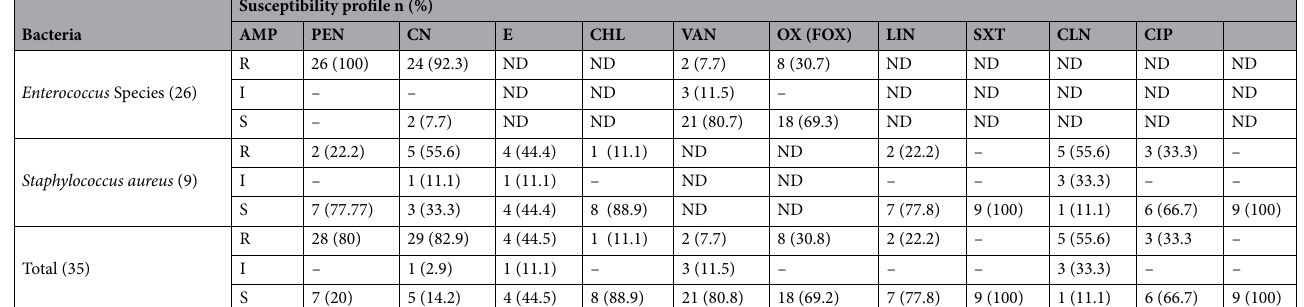
Table 6. Antibiotic susceptibility profile of Gram-positive bacteria isolated from newborn suspected of sepsis at Hawassa University Comprehensive specialized Hospital February 2021 to November 2021 (n = 35). AMP Ampicillin, P Penicillin, CN Gentamicin, E Erythromycin, CLN Clindamycin, SXT sulfamethoxazole- trimethoprim, CIP Ciprofloxacin, OX Oxacillin, VAN Vancomycin, CHL Chloramphenicol, IN Linezolid, R Resistance, I Intermediate, S Susceptible, ND not